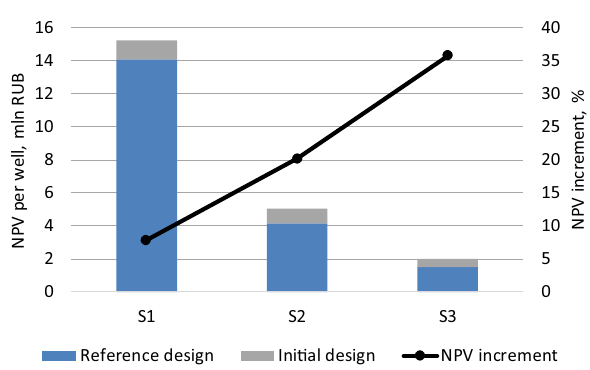
Fig. 9 Scenario 3 reference design well pad production and NPV profiles